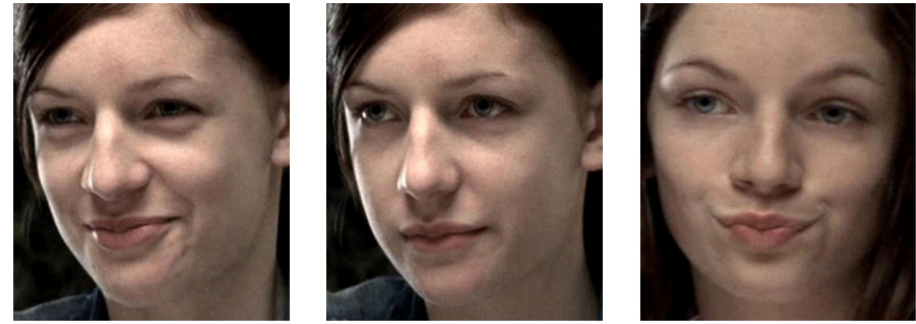
Figure 1. Sequence of events for an example trial of the films expression task.